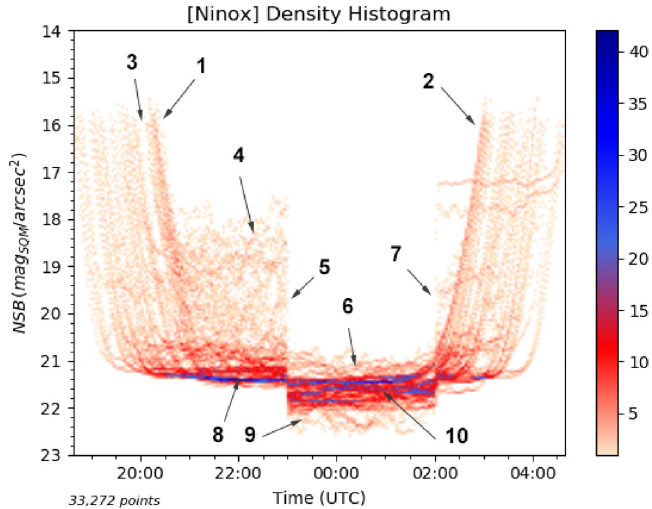
Figure 2. NSB density histogram recorded with a Ninox system at the Astrièves Observatory in Gresse-en- Vercors, France. The measures cover a period from the 29th of March, 2020 until the 12th of September, 2020. This represents 165 nights and more than 33,000 individual measures in moonless conditions. The blue regions in the diagram show where the maximum numbers of occurrences take place (up to 40 occurrences for dark blue) while the pale red color indicates infrequent